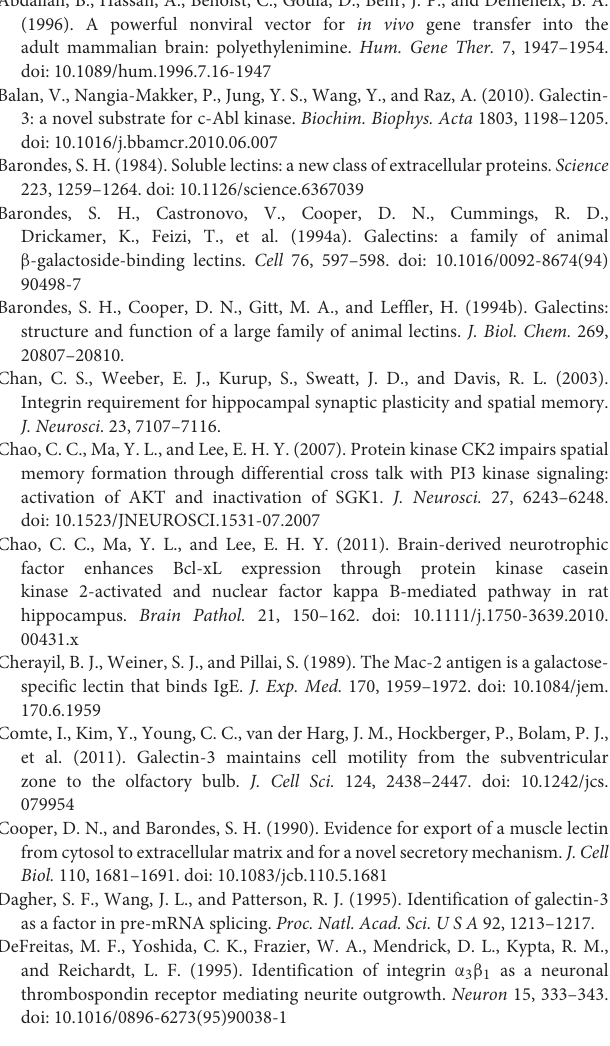
FIGURE S1 | (A) An illustration showing the position and inner diameter of the punch (dotted circle), and the CA1-containing tissue (marked by the oblique lines) that is punched out for biochemical assays in the rat. The lines in white color mark the boundary of the CA1 layer. Scale bar equals 500 µ m. (B) Immunohistochemistry in WT mice incubated with the FITC-conjugated secondary antibody only. Scale bar equals 200 µ m for the upper panel and it equals 100 µ m for the lower panel. (C) Immunohistochemistry of galectin-3 in galectin-3 KO mice. Scale bar equals 200 µ m for the upper panel it equals 100 µ m for the lower panel. Arrows in the lower panel of (B,C) indicate the same area as shown by arrows in the upper panel of (B,C) at a higher magnification. FIGURE S2 | Shock sensitivity measures are similar in WT and galectin-3 KO mice. The WT and galectin-3 KO mice were subjected to foot shock stimulation over a wide range of shock intensities and their (A) Motor score ( F ( 1,10 ) = 4.05, P > 0.05) and (B) Number of vocalizations ( F ( 1,10 ) = 0.15, P > 0.05) in response to these shocks are shown. N = 6 each group. Data are mean ± SEM.